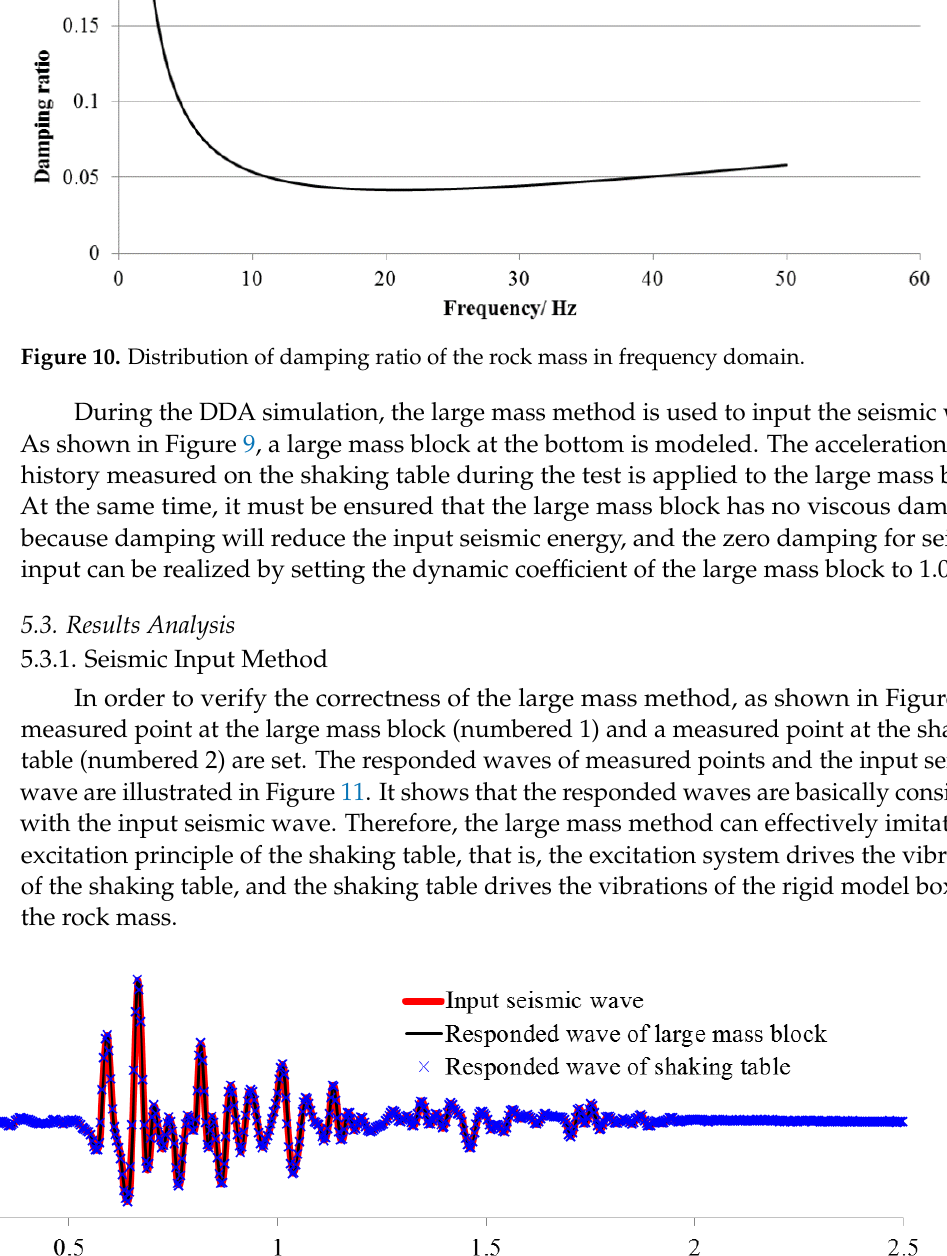
Figure 9. DDA model and the measured points.